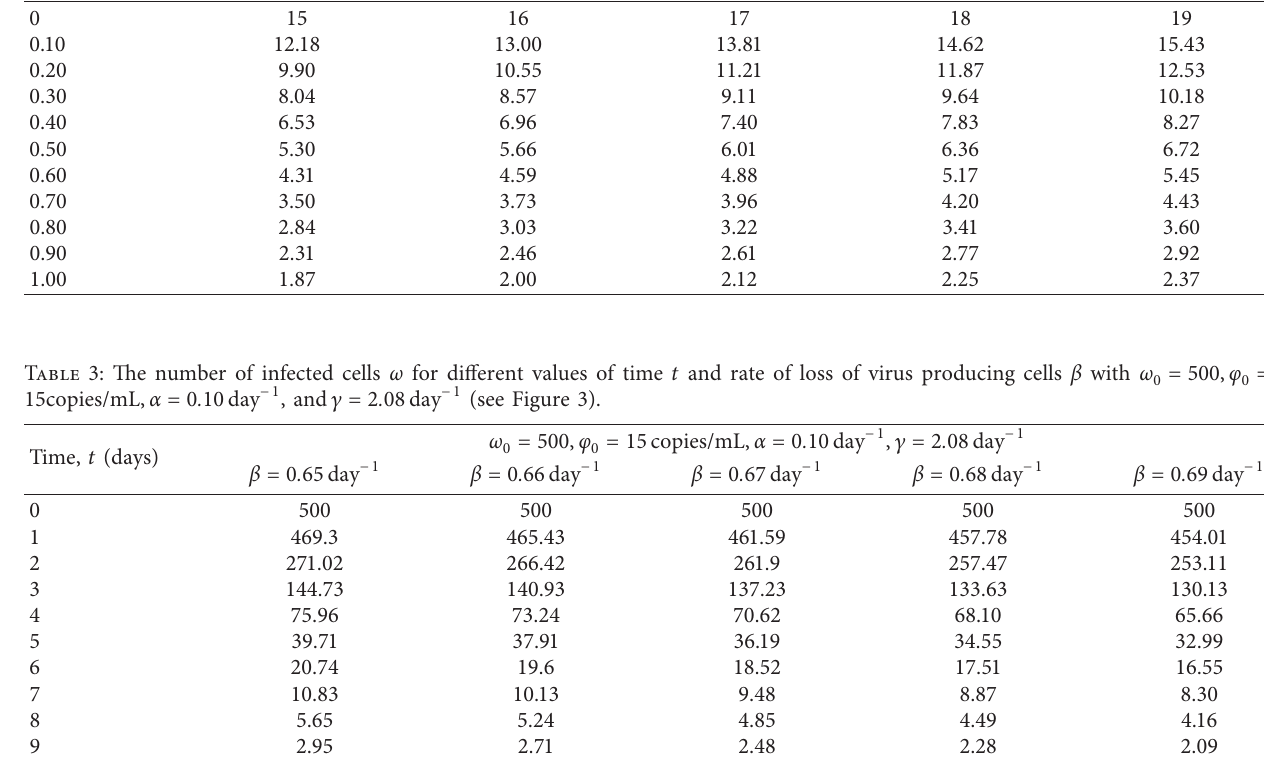
Table 2: Concentration of viral particles in plasma φ for different values of time t and initial concentration of viral particles in plasma φ with rate constant of viral particle clearance c � 2 . 08 day − 1 (see Figure 2). Time, t (days)